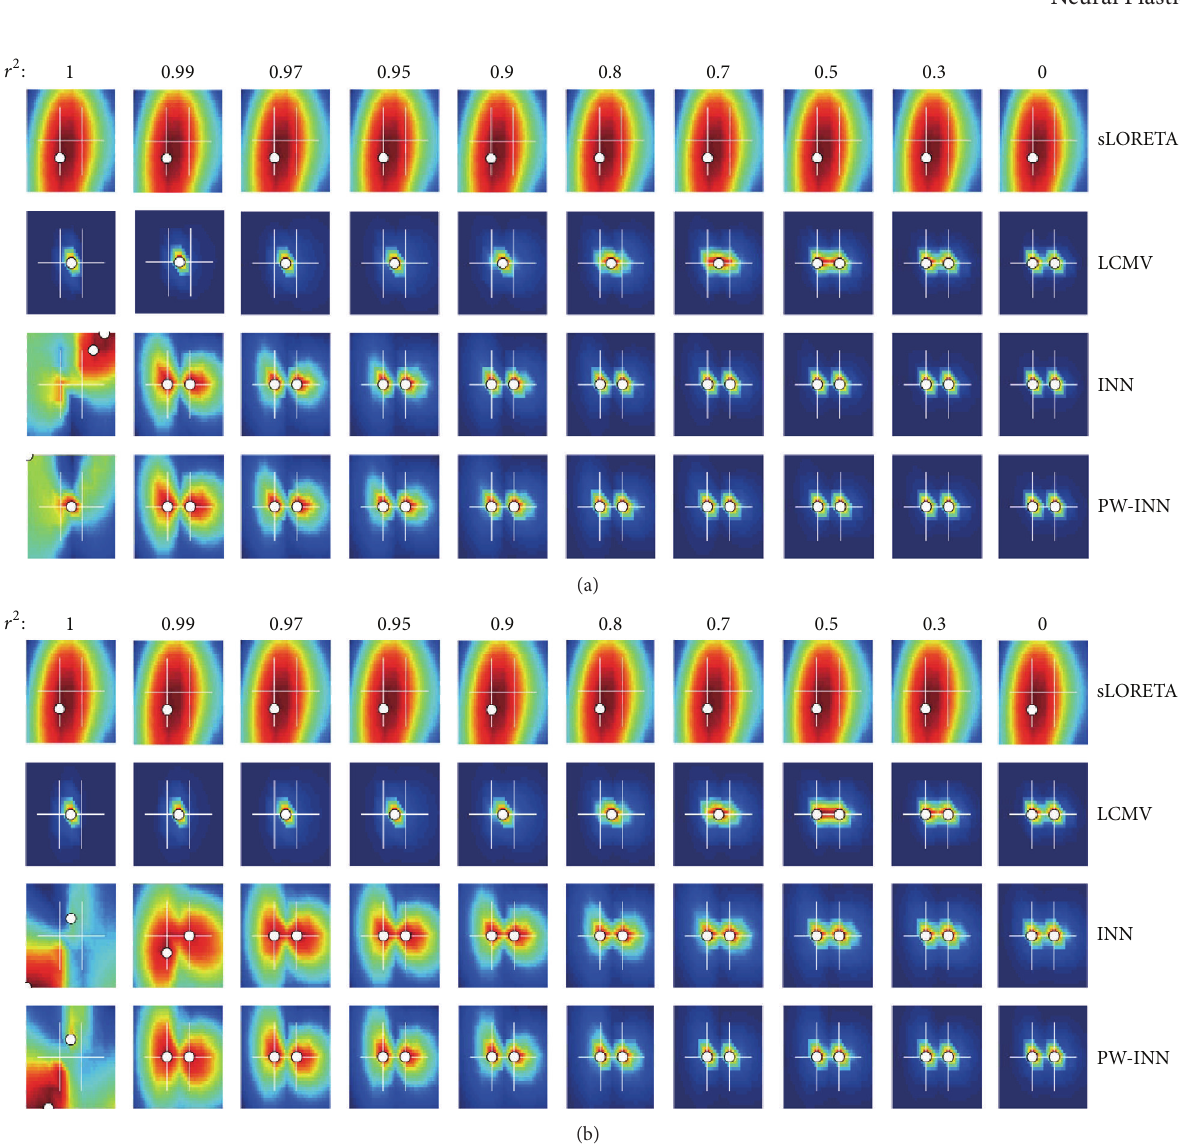
Figure 3: Performance comparison between sLORETA, LCMV beamformer, INN, and PW-INN in resolving closely spaced sources in presence of white noise (a) or real MEG noise (b). SNR is set to 18. Correlation coefficient ( 𝑟 2 ) varied from 1 to 0. From leftmost column to rightmost, 𝑟 2 is sequentially set to 1, 0.99, 0.97, 0.95, 0.9, 0.8, 0.7, 0.5, 0.3, and 0. White crosses indicate true source locations and white dots indicate estimated source locations. All results are obtained by averaging 100 independent